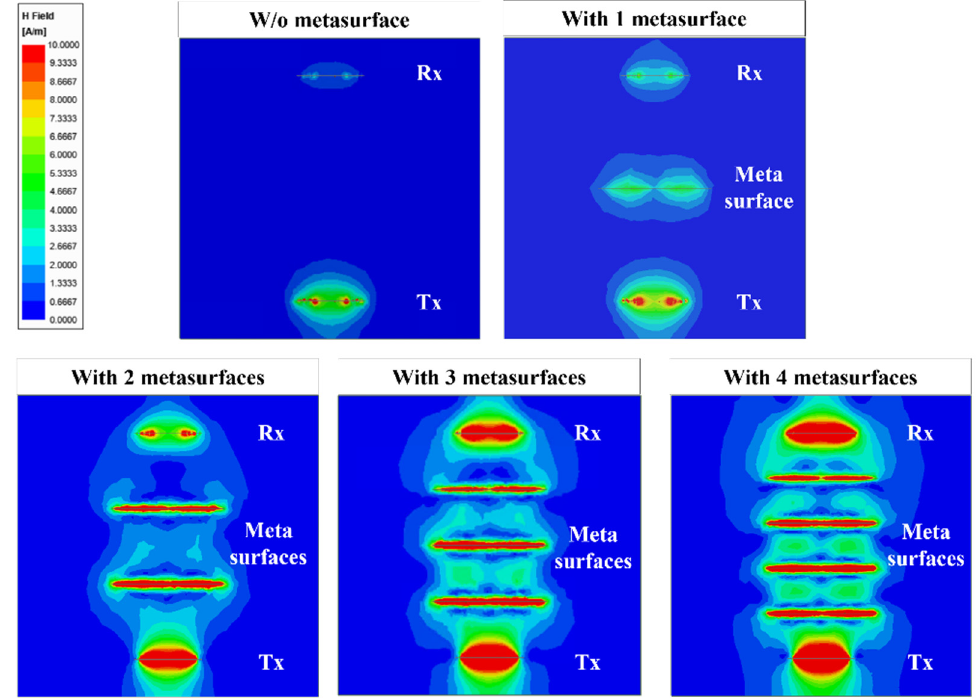
Figure 8. Comparison of magnetic-field distribution between the Tx and Rx without and with the MS screens.